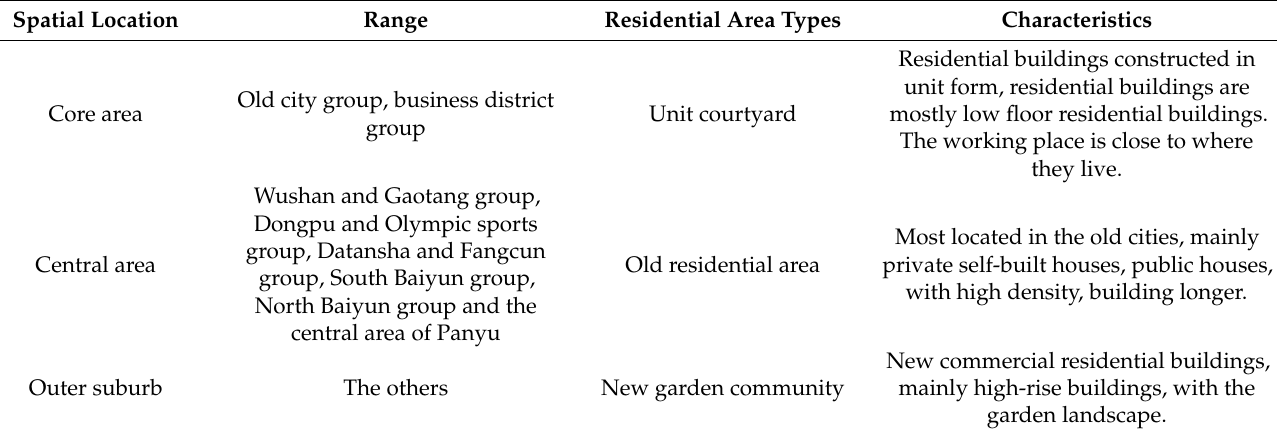
Table 1. The description of spatial location and types of residential area in Guangzhou.